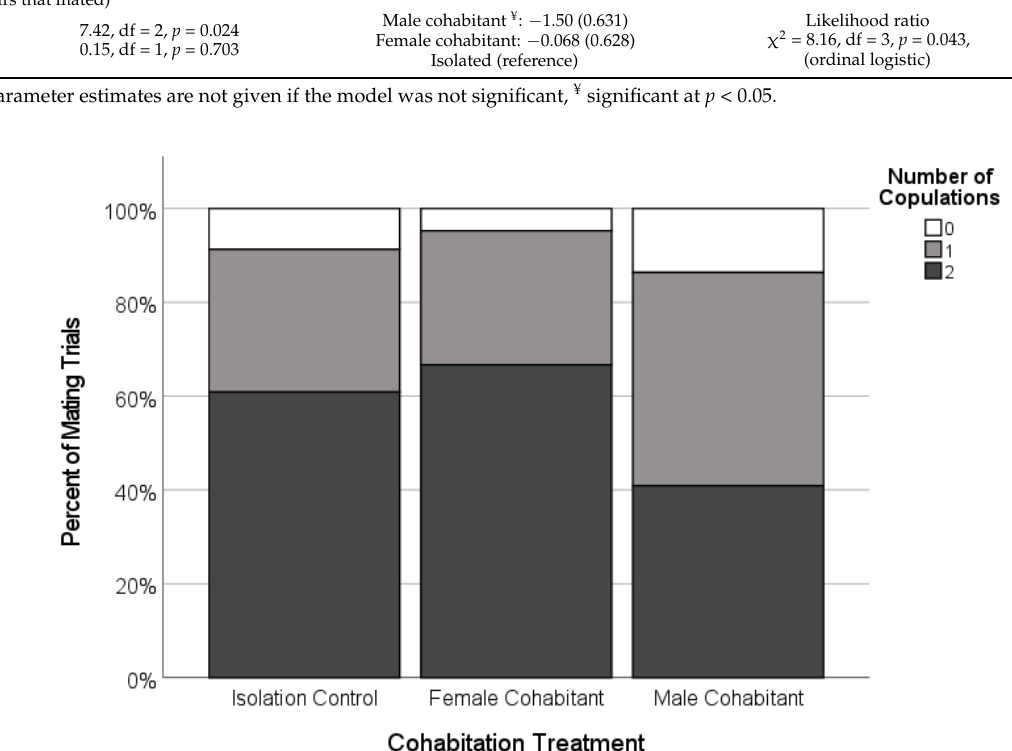
Figure 5. Copulation frequency of adult females paired with novel males as a function of the experimental social conditions during the female’s final subadult instar (Isolated, n = 23; Female-cohabitant, n = 21; Male-cohabitant, n = 22). Very few females did not copulate (white), and the proportion that copulated only once (light grey) or copulated twice (dark grey) was not significantly different across the treatments.